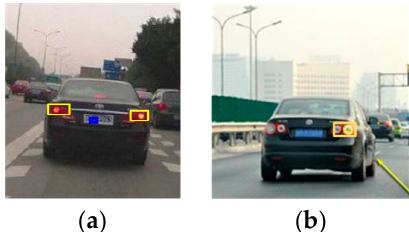
Figure 21. Taillight detection results. ( a ) Brake light detection results; ( b ) Direction light detection results.